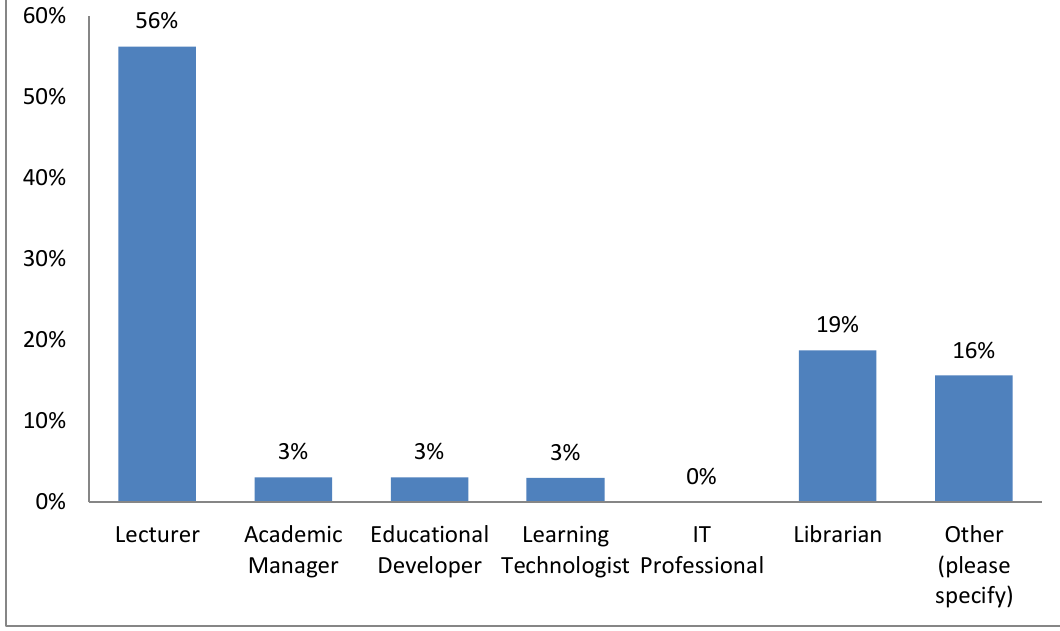
Fig. 4 Which of the following describes your role in